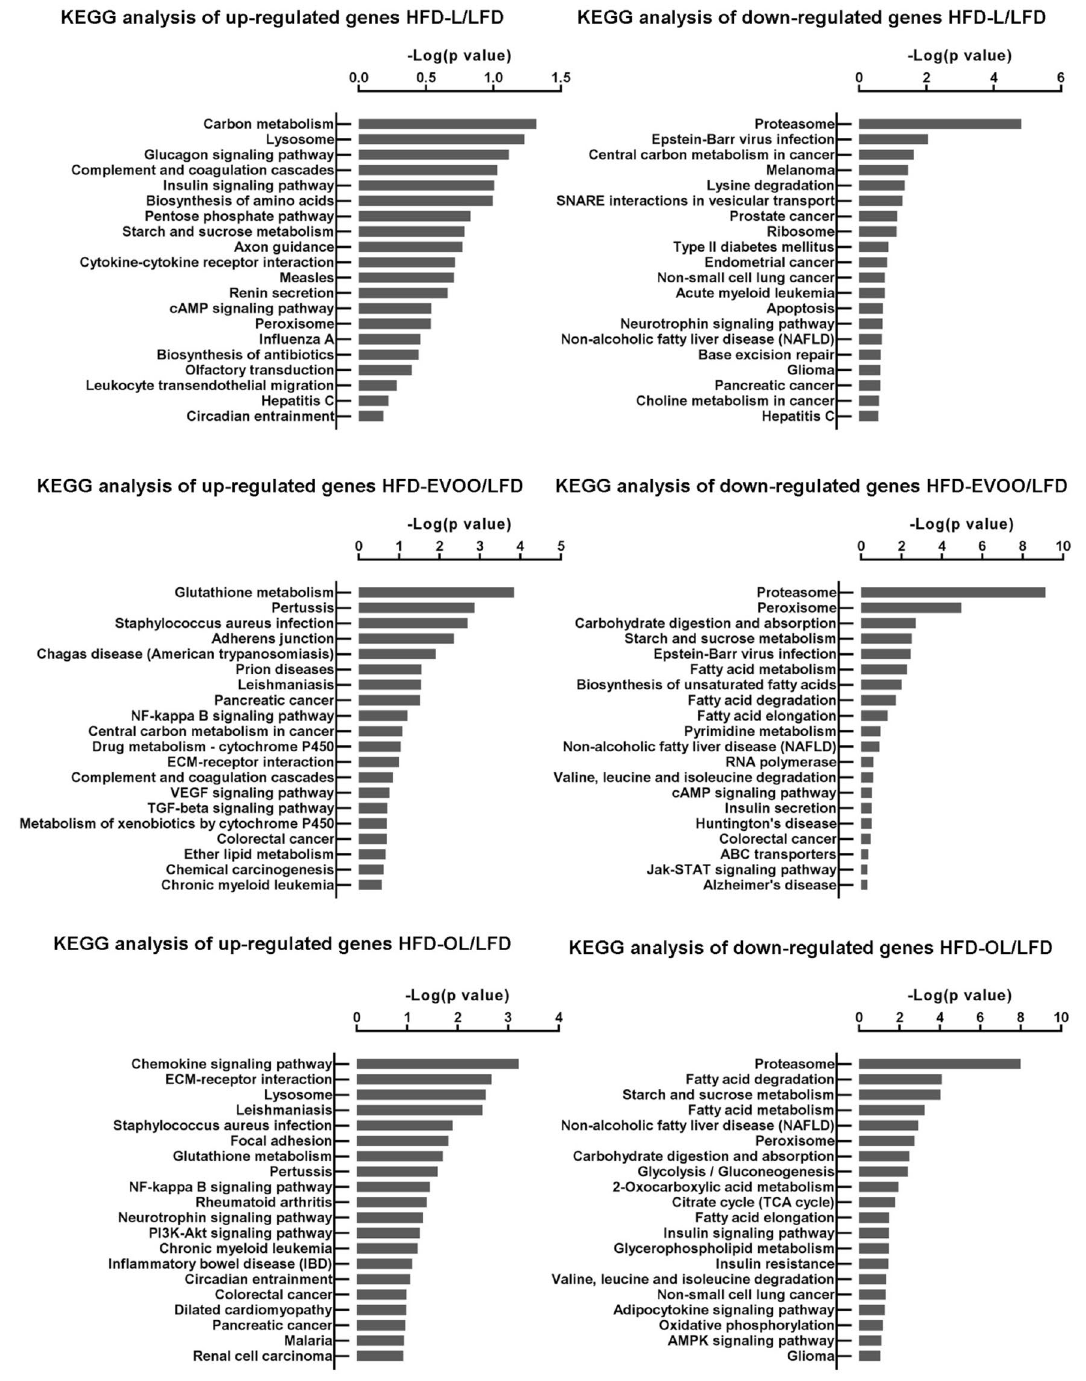
Figure 7. Predicted Biological Process GO terms identified using upregulated and downregulated DEG, in HDL, HDL-EVOO and/or HFD-OL relative to LFD, after 32 weeks of nutritional intervention study. DEGs were processed with DAVID tools v6.8. The p value was used to determine the significance of enrichment or overrepresentation of terms for each annotation. The ranking score was obtained using enrichment − log10 (p value) from the predicted target genes. The x-axis represents score and the y-axis represents the top enriched signaling pathways. The top 20 KEGG terms are listed as derived from the DAVID bioinformatics